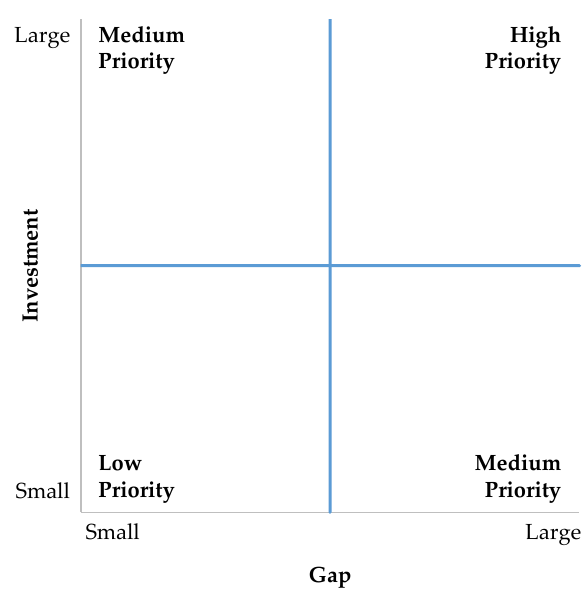
Figure 4. Conceptual model for the prioritization of corrective management action by balancing investment in an attribute and the gap in performance with respect to the expectations of PGI